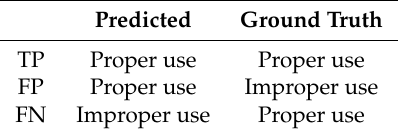
Table 3. Definitions of true positive (TP), false positive (FP), and false negative (FN). Predicted Ground Truth TP Proper use Proper use Proper use Improper use Improper use Proper